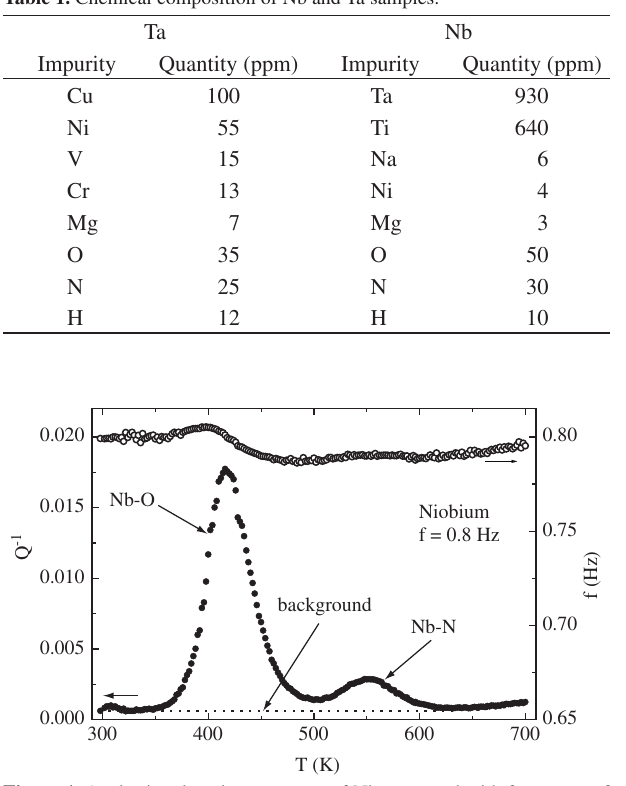
Figure 3. Frequency influence on internal friction for Nb-O relaxation process.